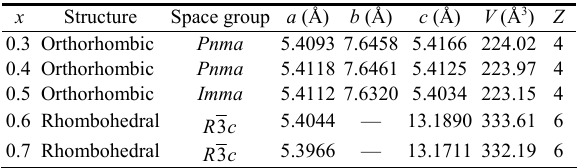
Table 1 Lattice parameters of the CTLA